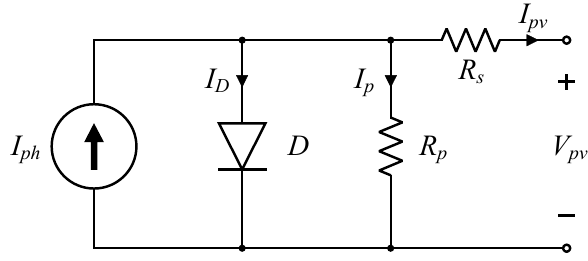
Figure 3. Comparison of PV panel property curve trends.